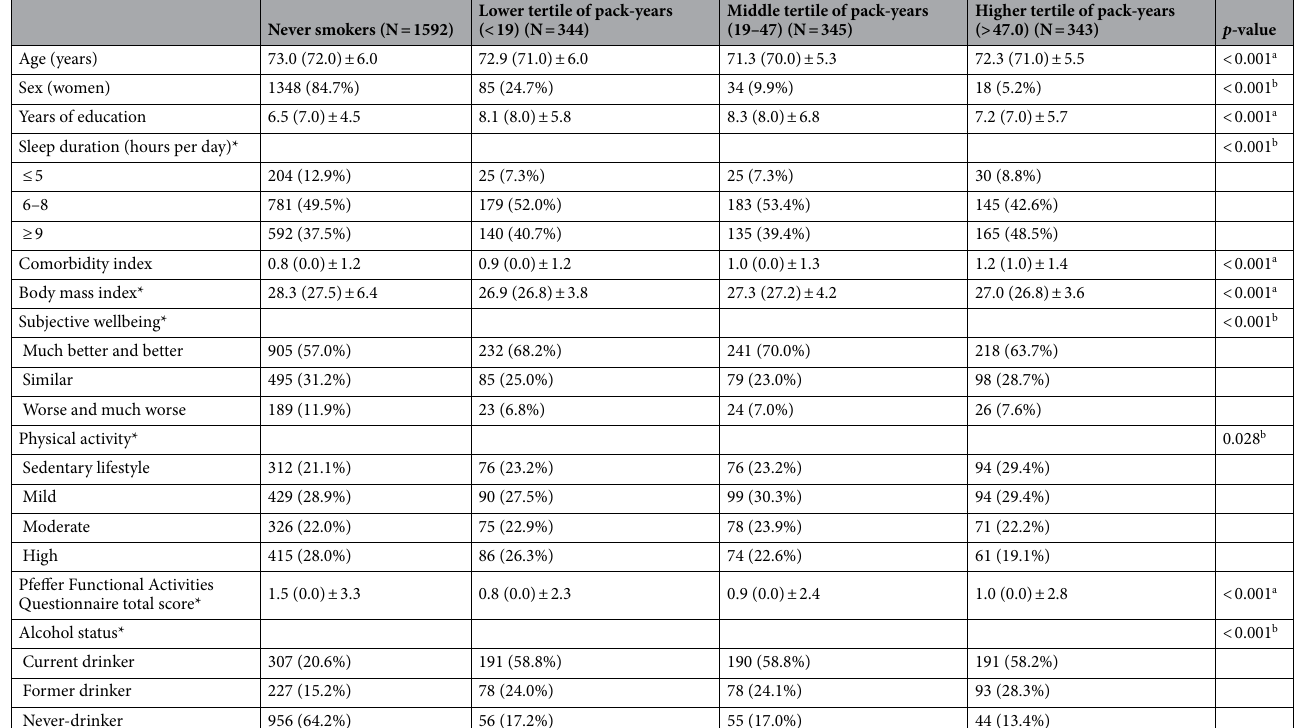
Table 2. Participants’ baseline demographic and clinical characteristics stratified by cumulative smoking exposure (N = 2624). a Kruskal–Wallis test; b Chi-square test. *Data on some participants were missing. Mean (median) ± standard deviation and frequency (%) are reported. MMSE-37 37-item version of the Mini-Mental State